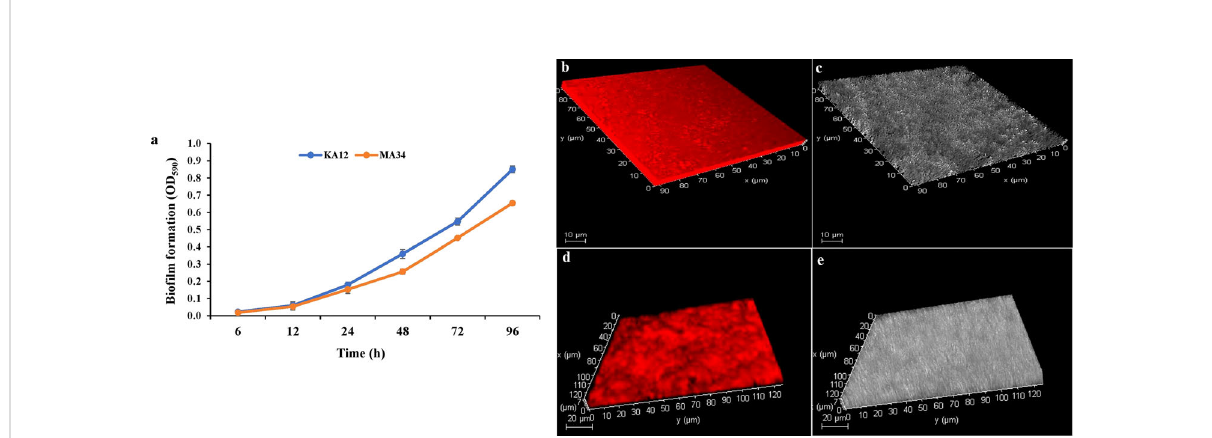
FIGURE 5 Bio fi lms measured with the crystal violet staining method and confocal laser scanning microscopy (CLSM). (A) Quanti fi cation of bio fi lm production at 96 h by KA12 and MA34 after elution of crystal violet stain by ethanol. Three-dimensional (3D) views of (B, C) KA12, (D, E) MA34 bio fi lms grown for 96 h. Actinobacteria were stained with acridine orange and observed by CLSM.